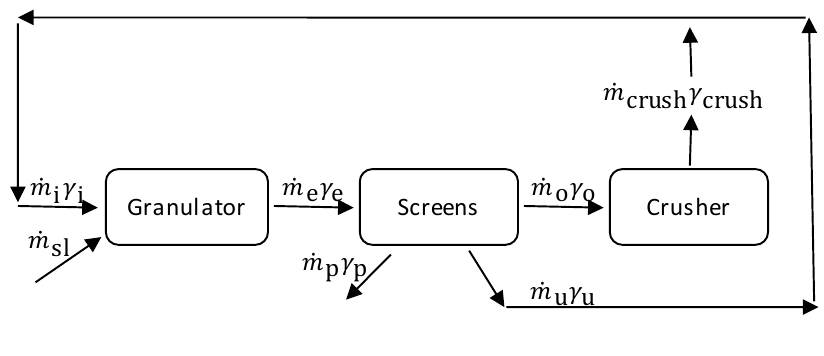
Figure 3: Simplified flow diagram of the drum granulation loop. Here, ˙ m sl is the slurry flow rate, ˙ m i , ˙ m e , ˙ m o , ˙ m u , ˙ m p , ˙ m crush are the mass flow rates of influent, effluent, over-sized, under-sized, product-sized and crushed particles respectively. The corresponding distribution functions of the influent, effluent, over-sized, under-sized, product-sized and crushed particles particles are denoted with γ i , γ e , γ o , γ u , and γ p , γ crush ,